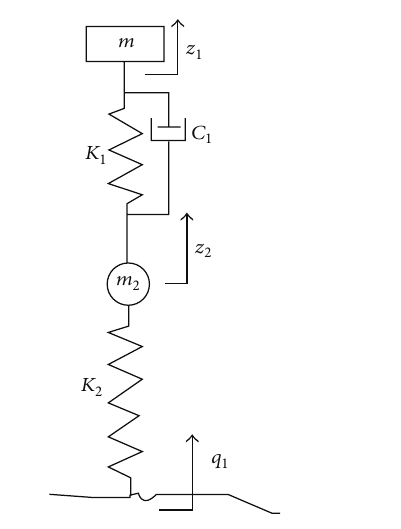
Figure 14: Vibration model of the front